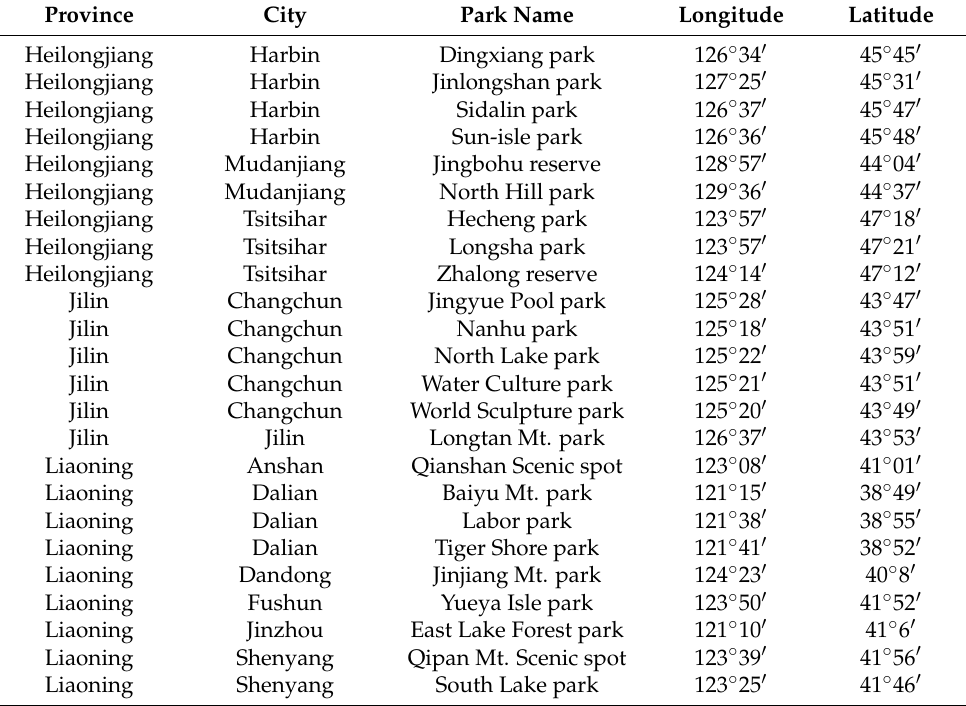
Table 1. Coordinates of urban forest parks located in cities of provinces at Northeast